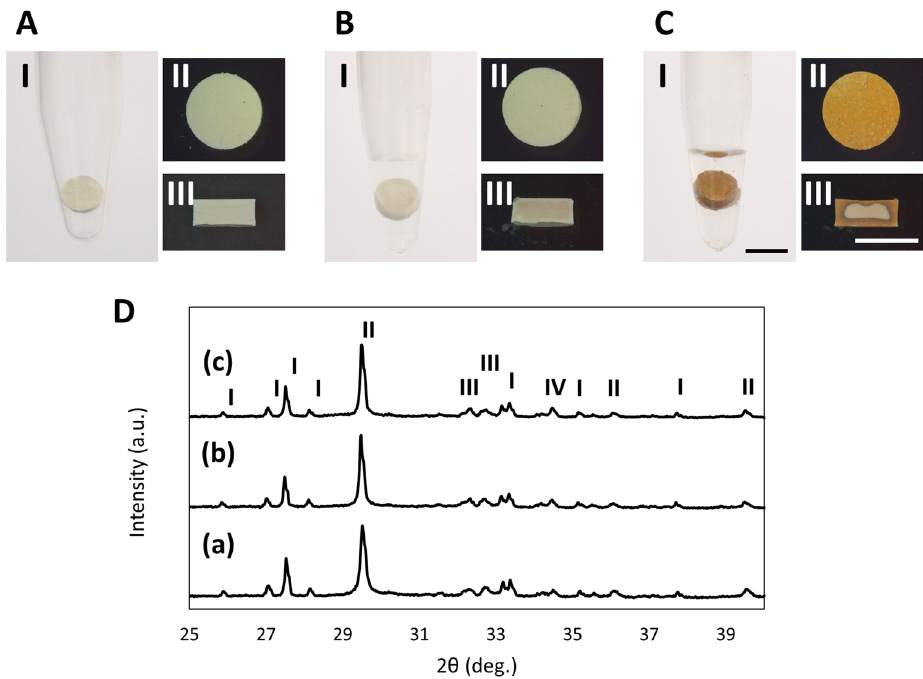
Figure 1. Photographic and x-ray diffraction analysis of WMTA discs immersed in NaOCl. ( A ) Images of WMTA discs before immersion (Cont-WMTA). ( B , C ) Images of WMTA discs after 24 h of immersion. WMTA discs were immersed in DW (D-WMTA) ( B ) or in NaOCl (Na-WMTA) ( C ). Photo (I) and stereomicroscopic (II) images of WMTA discs. (III) Stereomicroscopic images of cleaved WMTA discs. Bars = 5 mm. Experiments were performed in quadruplicate. ( D ) XRD patterns of Cont-WMTA (a), D-WMTA (b), and Na-WMTA (c). I: Bismite